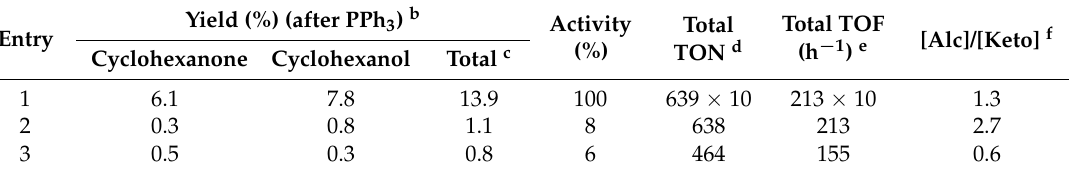
Table 4. Recycling of the system 1 + [bmim][NTf 2 ] a .